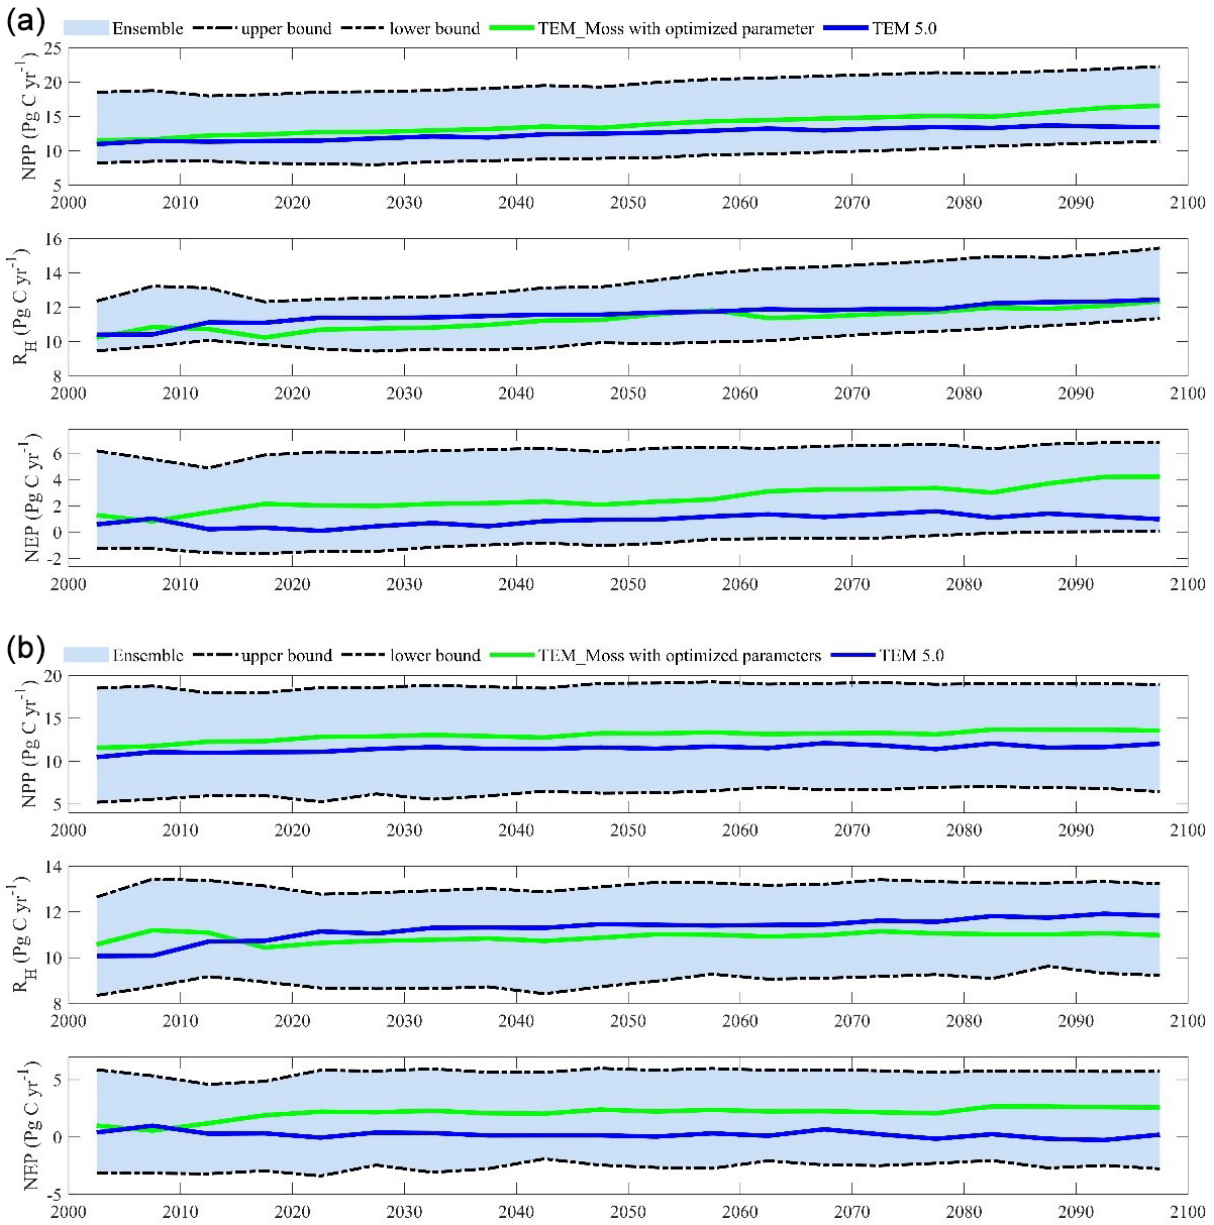
Figure 15. The 5-year moving average plots for carbon fluxes under the (a) RCP2.6 scenario and (b) RCP8.5 scenario. The blue area represents the upper and lower bounds of